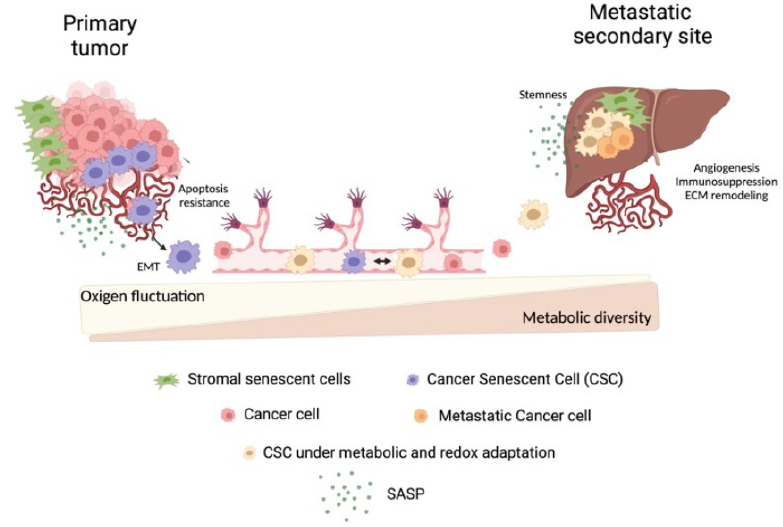
Figure 3. Summary of the intrinsic and extrinsic plasticity of senescent cells.